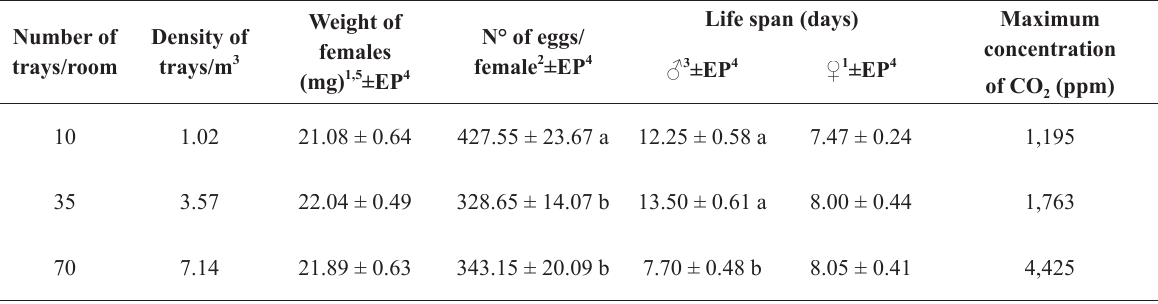
2 (ppm) inside the 2